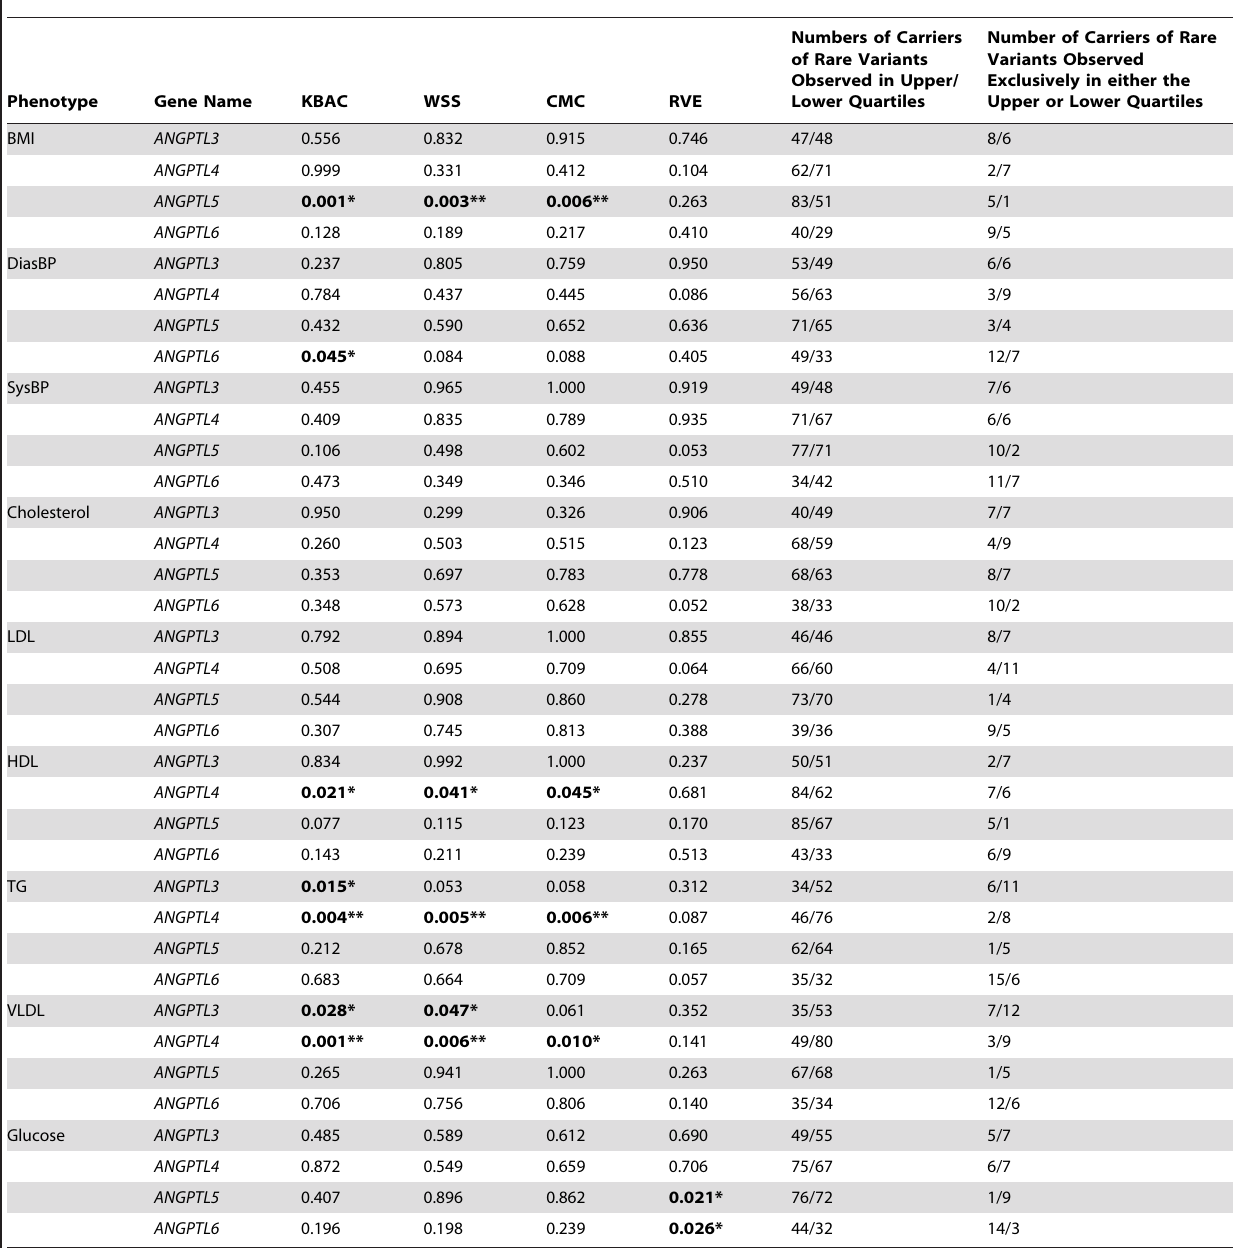
Table 3. Association analyses of the ANGPTL 3 , 4 , 5 and 6 gene variants with human energy metabolism